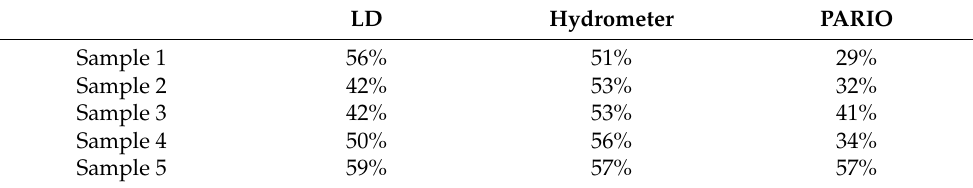
Table A2. Representation of the particles smaller than 10 µ m obtained by three tested methods.